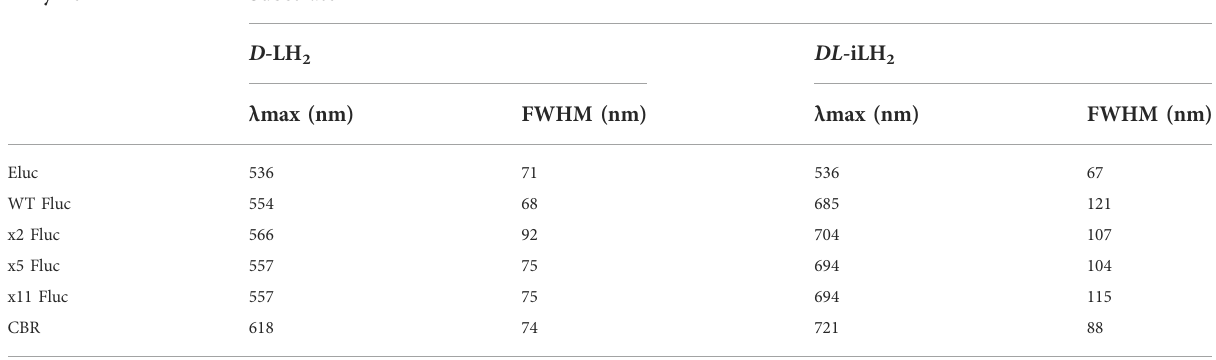
TABLE 1 Bioluminescence spectral λ max and full-width half maxima. Data were acquired using the Clariostar instrument. Experimental details are as shown in Figure 3A. Enzyme